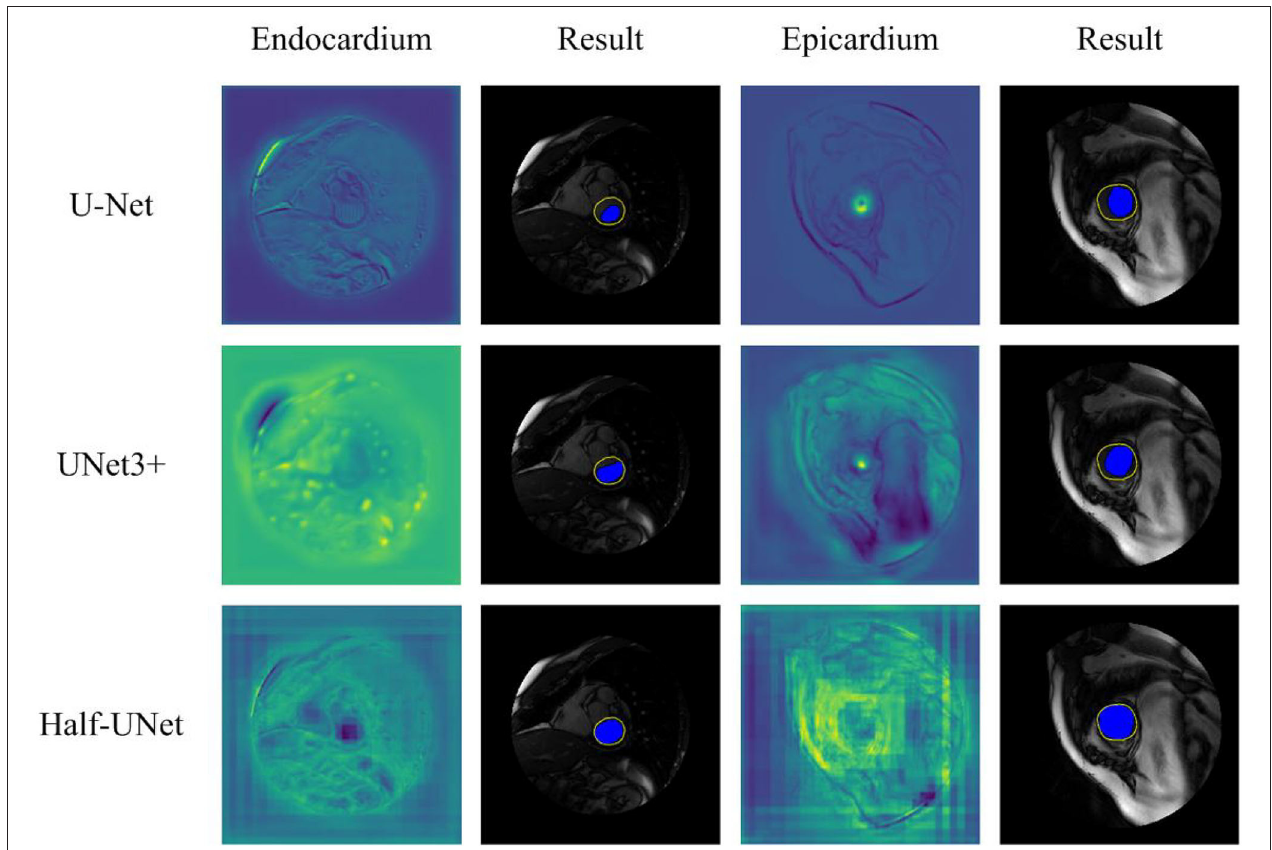
FIGURE 5 | Qualitative comparison between Half-UNet, U-Net, and UNet3+ in left ventricular MRI. Endocardium and Epicardium columns show feature maps. Result columns show final segmentation results, in which the yellow hollow area represents the ground-truth, and the blue solid area represents the automatic segmentation result.